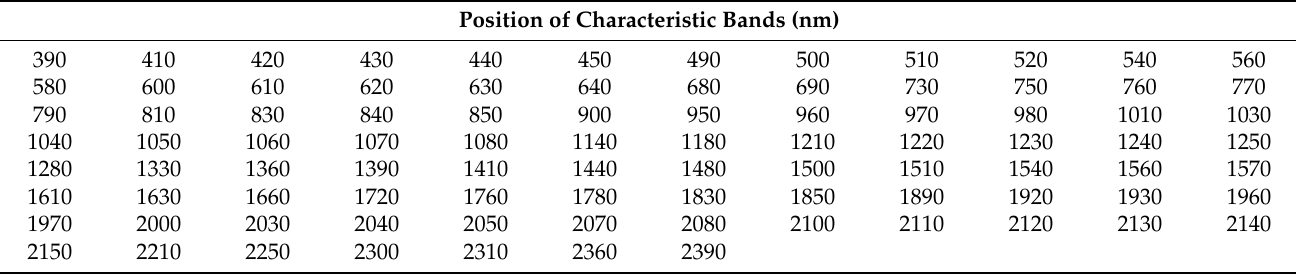
Table A5. Characteristic bands of CR-LN selected by